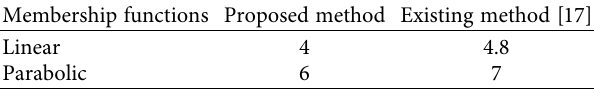
Table 5: Comparison of the proposed method with the existing method